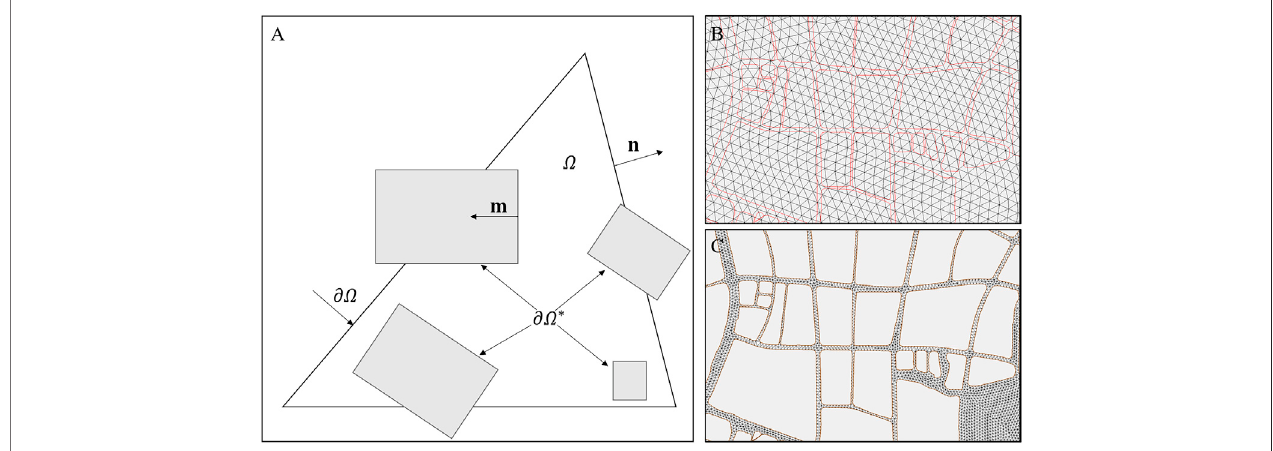
FIGURE1|(A) Conceptualmodelofanisotropicporosityonatriangulargrid,andexamplesofcomputationalgridsfor. (B) porousshallowwatermodeling(PSWM) and (C) classical shallow water modeling (CSWM).